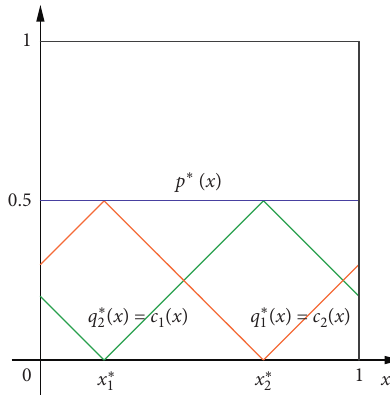
Figure 4: Price and quantity curves with equilibrium positions at opposite ends of a